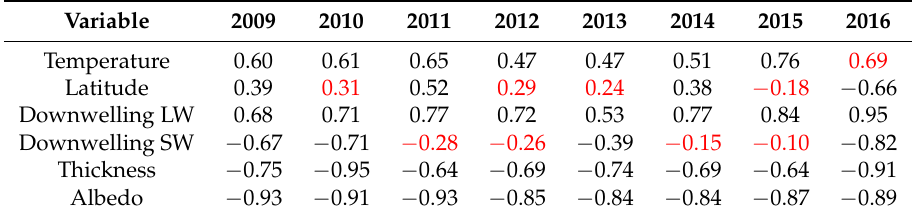
Table 3. Pearson correlations between studied variables and total change in concentration for 2009–2016. Values with p > 0.05 are shown in red.